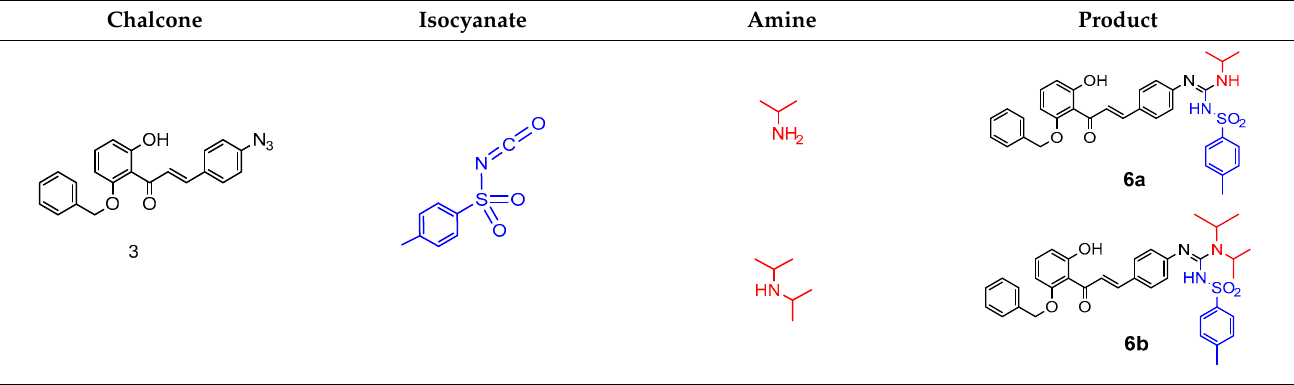
Table 1. Azidochalcone, isocyanates, and amines as starting reagents to generate the corresponding guanidine–chalcone hybrids.